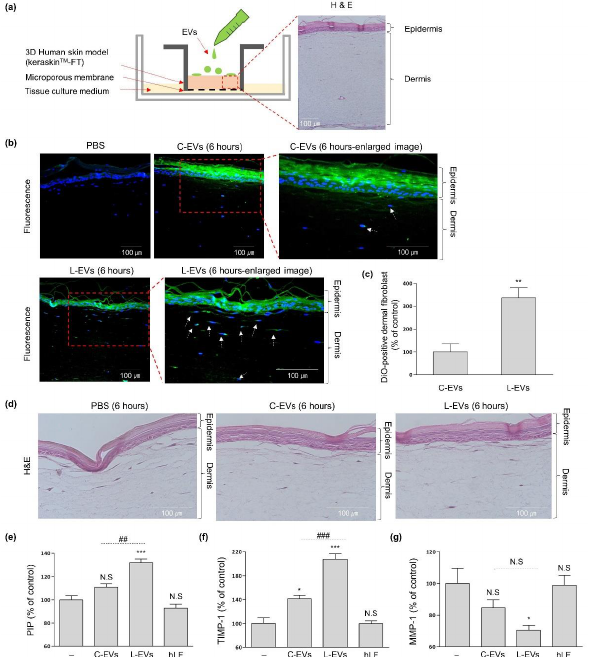
Figure 4. The effect of L-EVs permeability and ECM synthesis on skin tissue. L-EVs and C-EVs were derived from the same number of hADSC respectively. ( a ) Schematic diagram of EVs permeation in KeraSkin TM -FT and H&E cross-section image of skin model. Scale bars = 100 µm. ( b ) Human 3D skin models were treated with DiO-labeled EVs for 6 h. Scale bars = 100 µm. The permeation of EVs in skin tissue was investigated by a cross-section of the tissue. In 6 h enlarged image, the maximum fluorescence of L-EVs was found in the upper layer of the dermis. The white arrows indicate DiO- positive cells. ( c ) After 6 h treatment of EVs, DiO and DAPI-double positive cells of the dermis layer were counted at three independent cross-section of tissue (unpaired t-test, n = 3, p = 0.0064). ( d ) H&E cross-section image after treatment of EVs for 6 h. ( e , f , g ) After EVs or hLF (10 µg/mL) were treated for 48 h, the amount of PIP, TIMP-1, and MMP-1 secreted from the KeraSkin TM -FT into the media (tissue culture media) was collected and analyzed. ( c , e , f , g ) The value of the negative control was considered to be 100%, while those of the other groups were calculated as relative values. The PIP, TIMP-1, and MMP-1 values were statically analyzed using one-way ANOVA (PIP: n > 3, p < 0.0001; TIMP-1: n = 3, p < 0.0001; MMP-1: n = 3, p = 0.0382). The data were obtained through three independ- ent experimental groups and significance between pairs were analyzed usin g post hoc, Tukey’s test. Error bars represent ±SD. * p < 0.05, ** p < 0.01, *** p < 0.001 were calculated versus the negative control. In the case of the pair connected by the dotted line, the difference between them was noted as ## p < 0.01, ### p < 0.001, N.S (Not Significant) p > 0.05.